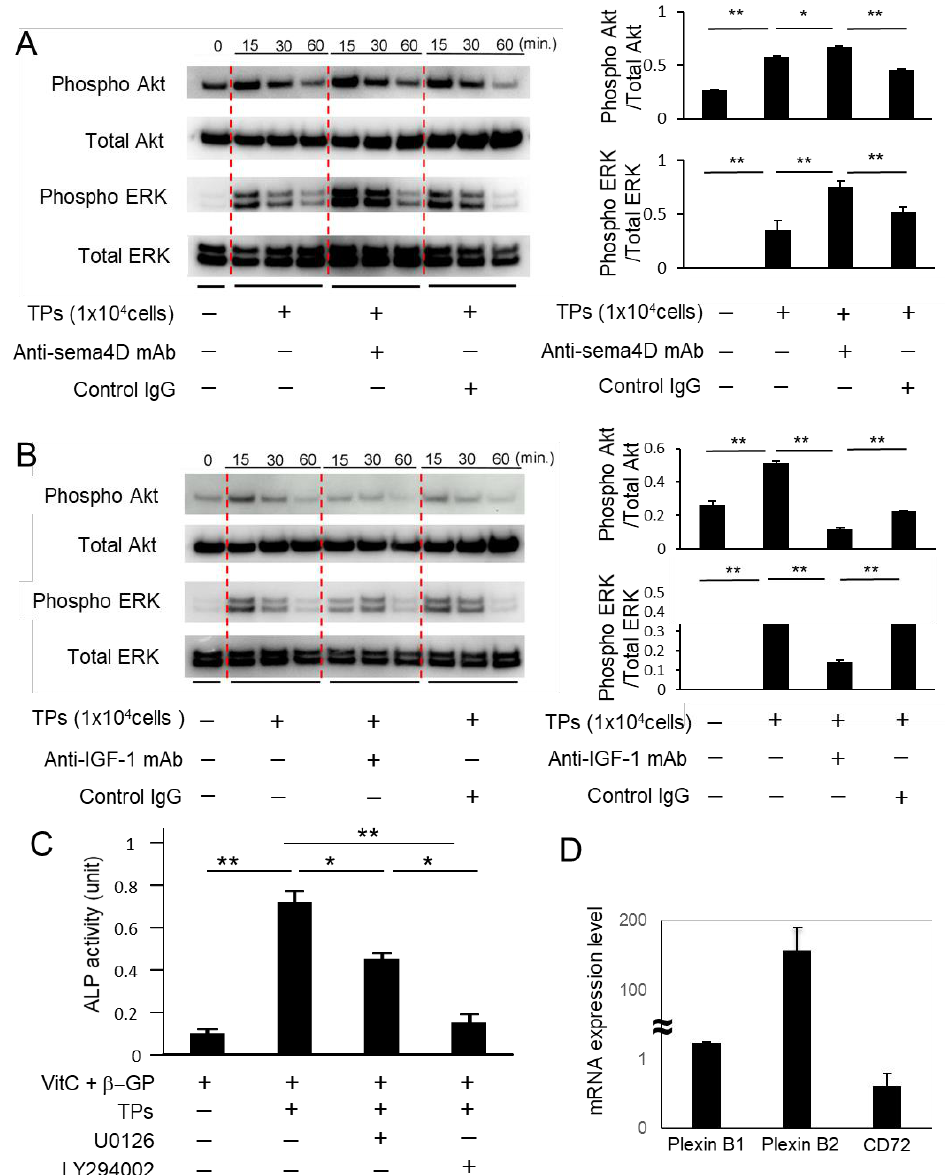
Figure 3. The effect of Sema4D and IGF-1 derived from TPs on ERK and Akt phosphorylation in MC3T3-E1 cells. Western blotting was performed to detect total and phosphorylated ERK and Akt in MC3T3-E1 cells cultured with/without ant-Sema4D mAb (50 µg/mL) or control mAb (50 µg/mL) in the presence of TPs ( A ) and total and phosphorylated ERK and Akt in MC3T3-E1 cells cultured with/without ant-IGF-1 mAb (1 µg/mL) in the presence of TPs ( B ). ALP activity was measured in TP-mediated MC3T3-E1 cells with and without ERK or Akt inhibitor ( C ). The mRNA expression of PlexinB1, PlexinB2 and CD72 in MC3T3-E1 cells was evaluated by qPCR ( D ). Data represent the mean ± SD of three independent experiments. Values are mean ± S.D. * p < 0.05, ** p < 0.01. +: Applied. − : Not applied.